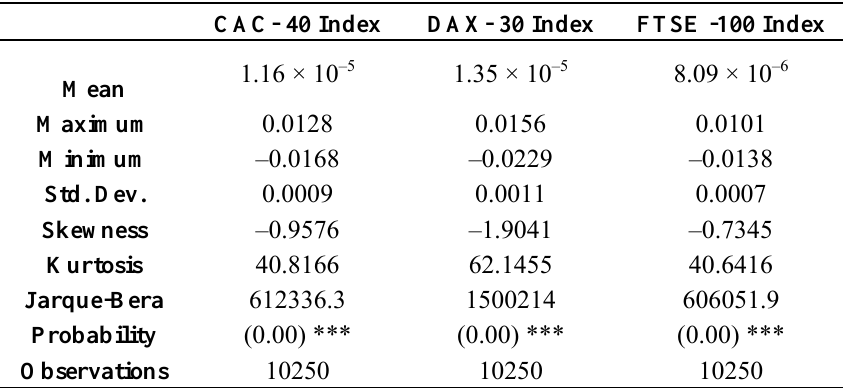
Table 2. Descriptive Statistics of Intraday